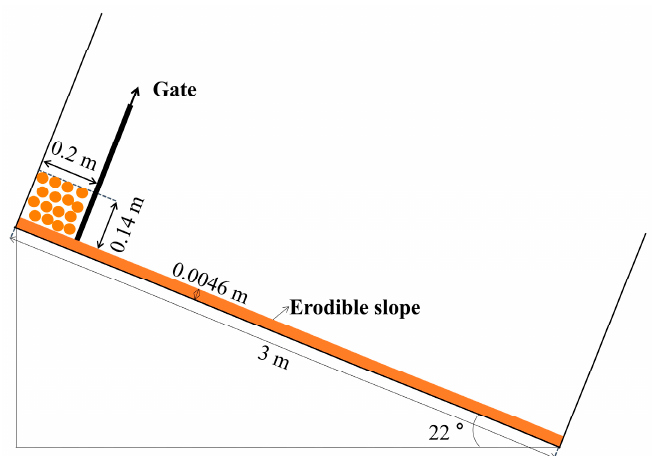
Figure 2. Diagram of the test setup.